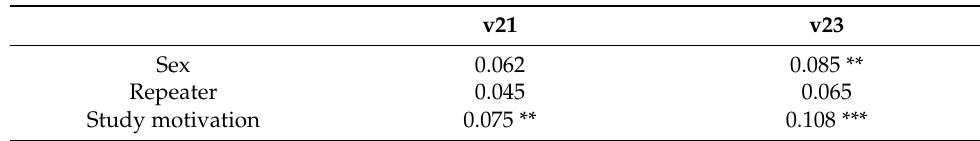
Table 8. Cramer’s V test. Perception of the instruments used to assess the degree of attainment of the competences. v21 v23 Sex 0.062 0.085 ** Repeater 0.045 0.065 Study motivation 0.075 ** 0.108 ***